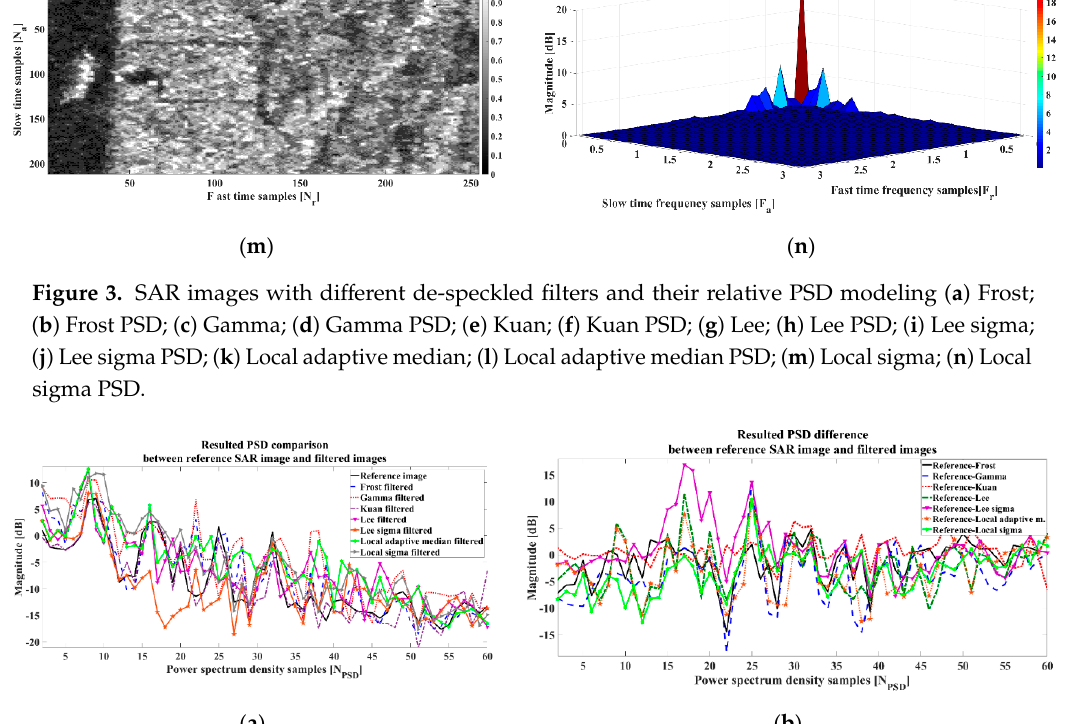
Table 1. PSD modeling results after HMS suppression. Column De-Speckling Filter